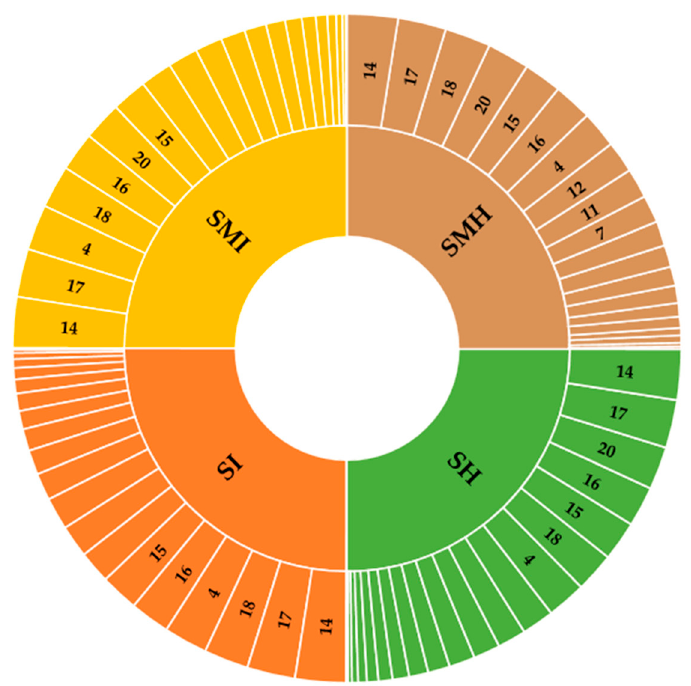
Figure 2. Comparison of ranges among isolates and hydrolysates of soybean and soybean-maize by the Kruskal–Wallis test ( p < 0.05).